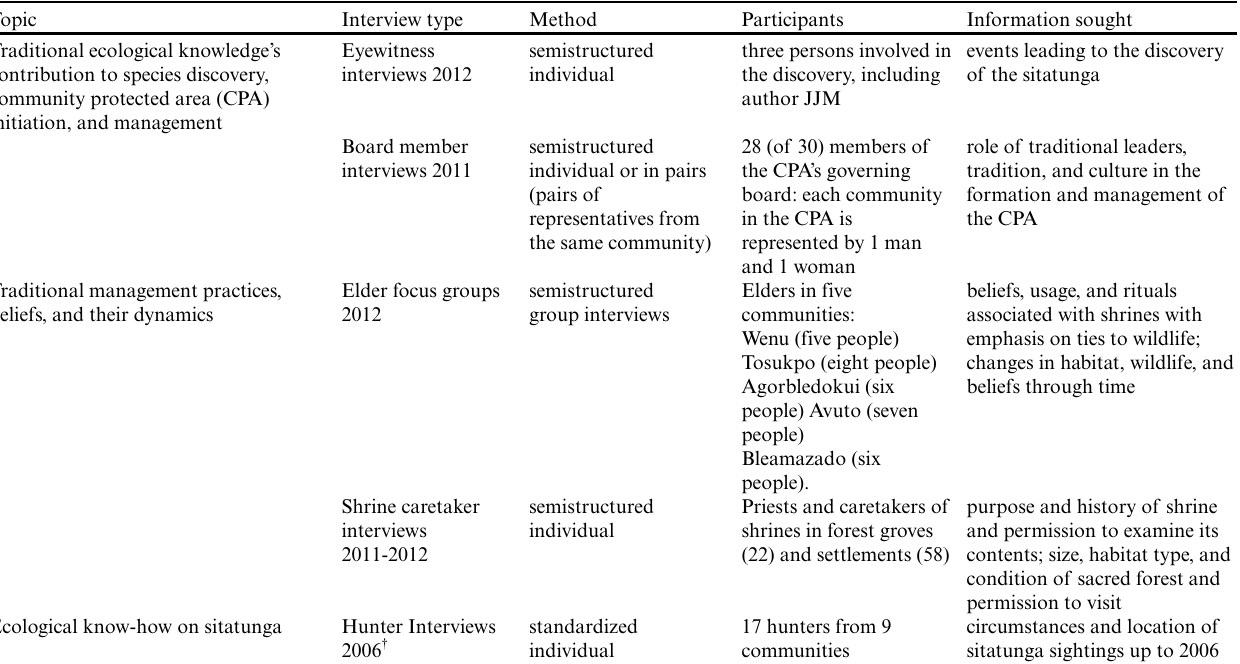
Table 1 . Summary of interviews conducted, indicating interview method, participants, and subject of enquiry. Participants were identified by peer selection (Huntington 2000), and all interviews were facilitated by a